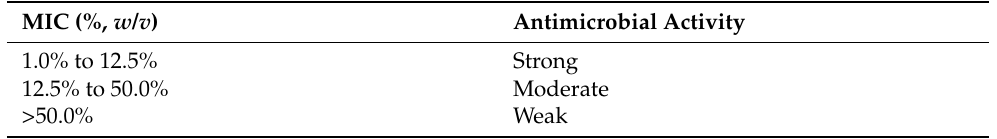
Table 2. Parameters for determination of the antimicrobial potency of honey samples. MIC (%, w / v ) Antimicrobial Activity 1.0% to